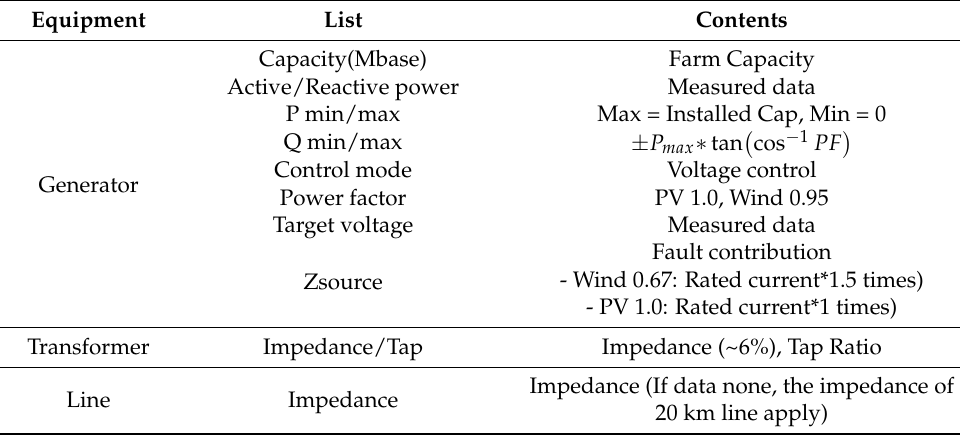
Table A1. Power flow model of the renewable energy.